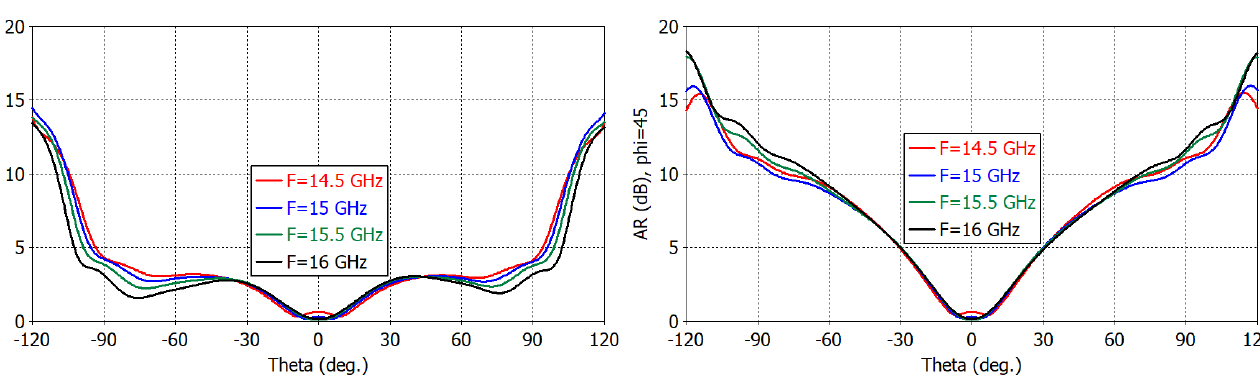
Figure 8. RHCP phase patterns of the sum channel.